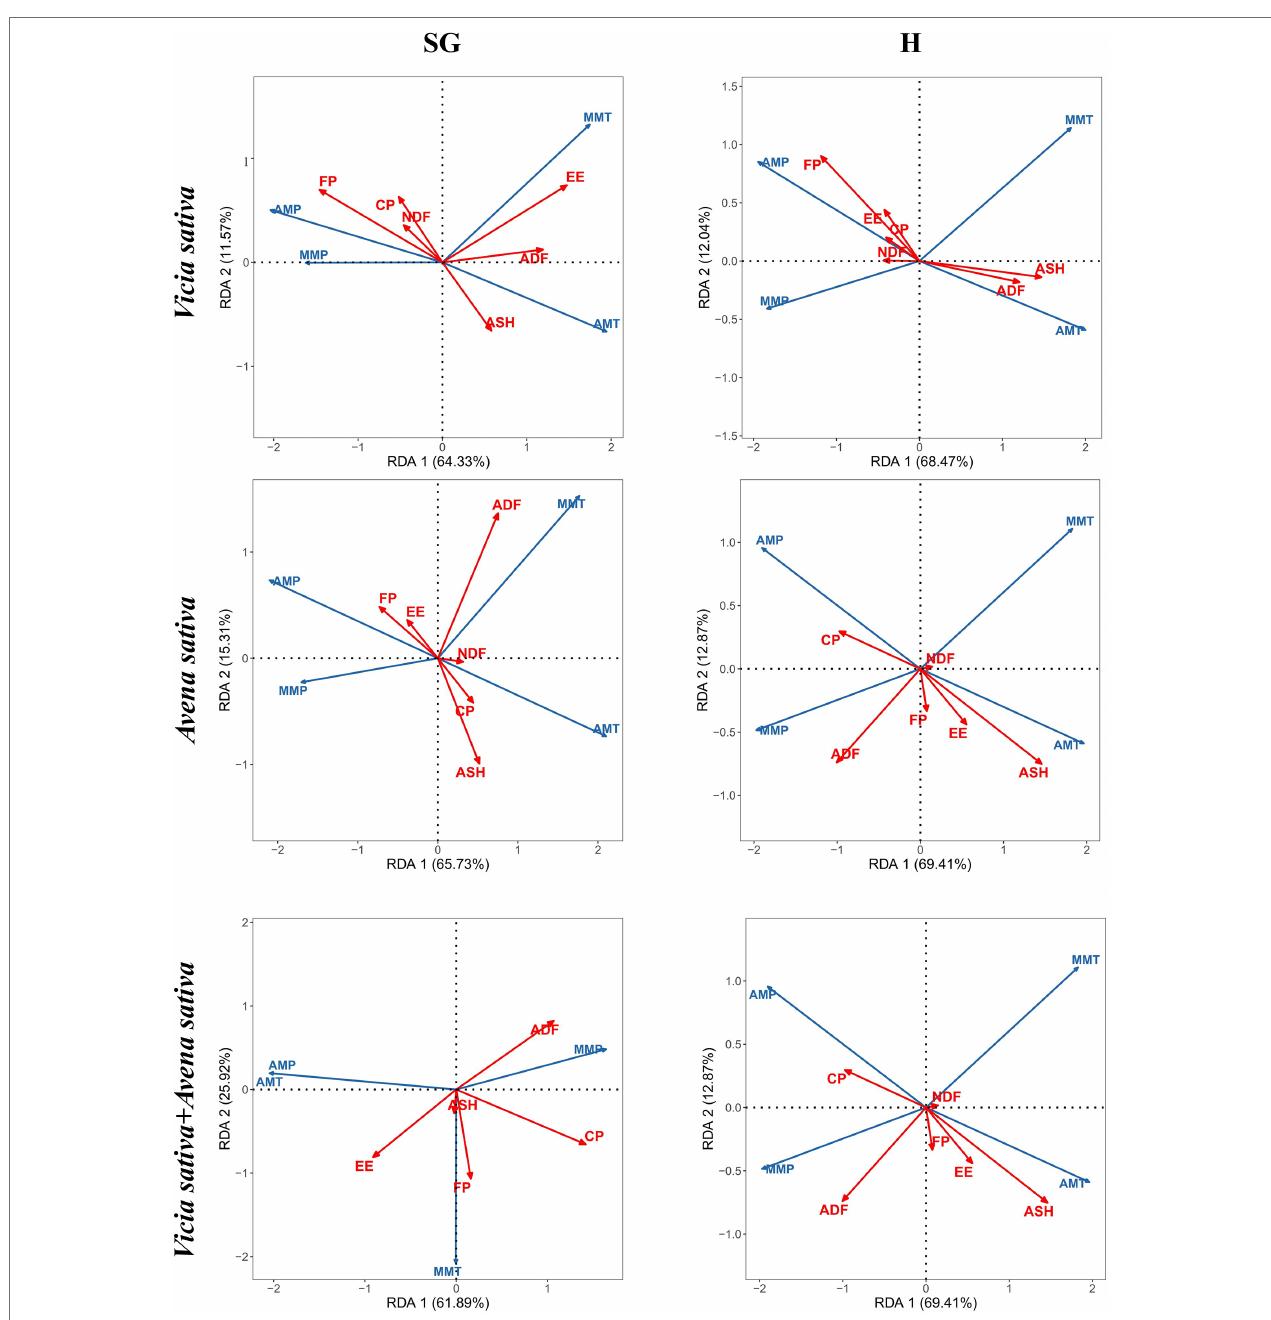
FIGURE 7 | Biplot of the first two axes of the distance-based redundancy analysis for forage yield and herbage quality associated with various ecological characteristics under simulated grazing. FP, forage yield; AMT, annual mean temperature; AMP, annual mean precipitation; MMT, month mean temperature; MMP, month mean